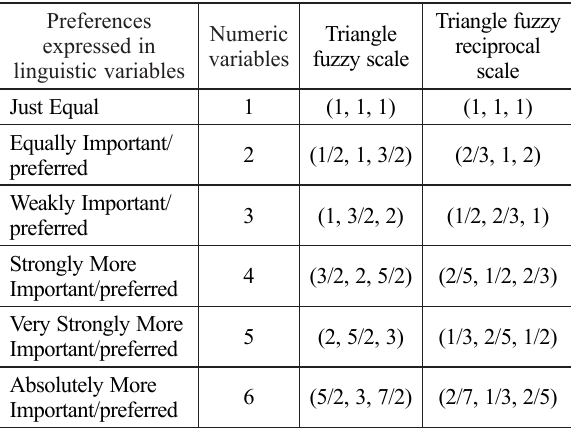
Table 2. Triangle fuzzy scale (Chang 1996)